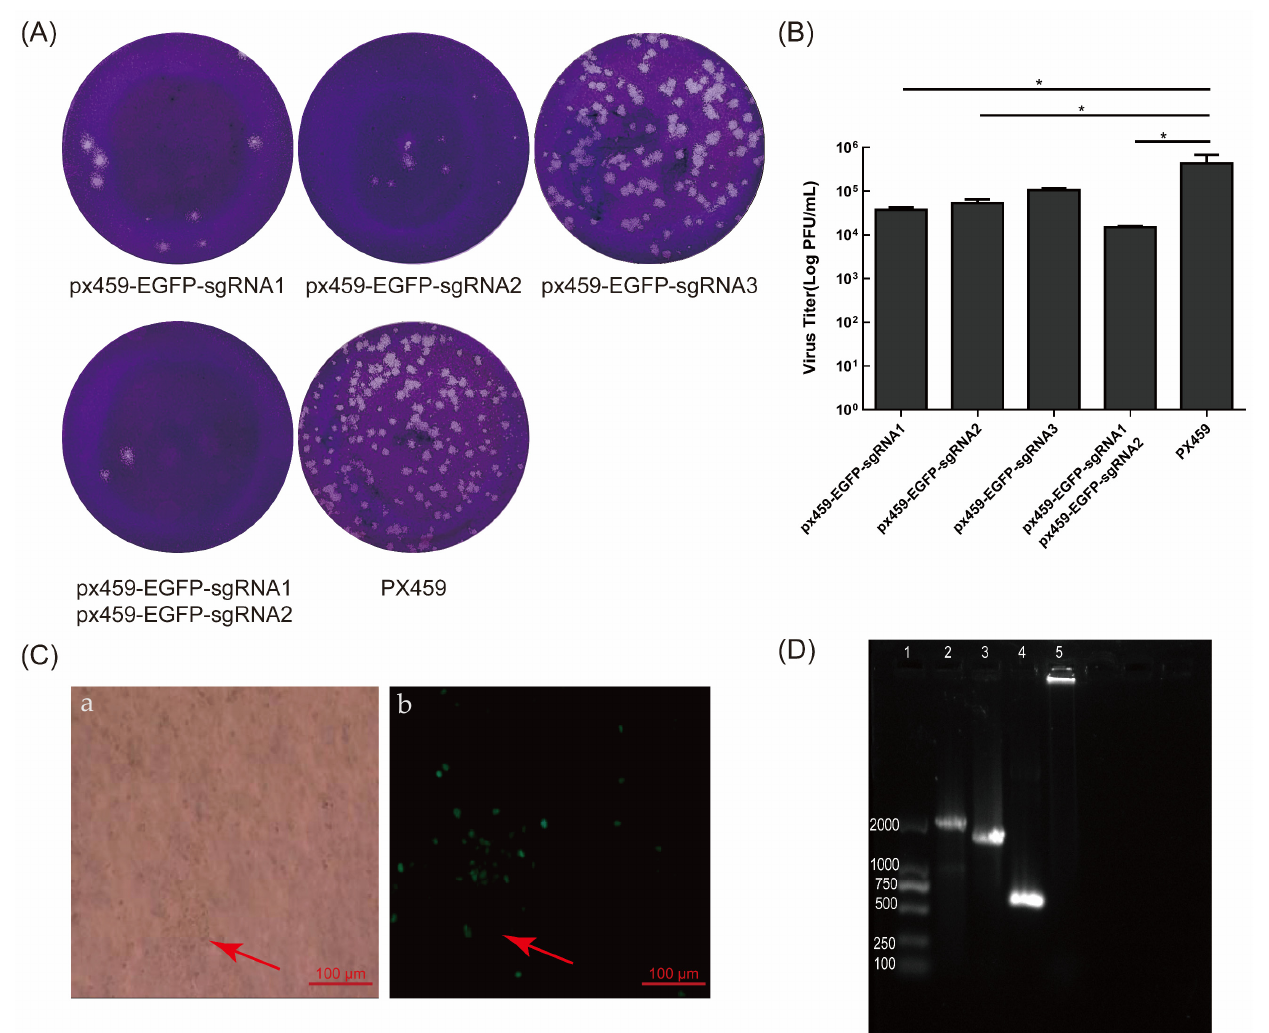
Figure 3. sgRNA of EGFP inhibited the formation of BoHV-1 gE/EGFP + plaques and the targeted deletion of EGFP. ( A ) The plaques with different sgRNAs of EGFP. Two micrograms of px459-gE- sgRNA1, 2, 3, or px459 were transfected into VERO E6 cells. After 12 h, the cells were infected with BoHV-1 gE/EGFP + (MOI = 1) and the virus was fixed and stained for plaque testing at 72 hpi. ( B ) The virus titer with sgRNA of EGFP editing on MDBK cells. ( C ) The cytopathic effect and no fluorescence of BoHV-1 gE/EGFP − ( Ca ) bright field; ( Cb ) fluorescence field. The red arrow indicates first-generation BoHV-1 gE/EGFP − recombinant viruses. ( D ) PCR identification of BoHV-1 gE/EGFP − . The purified viral genome was extracted and PCR amplification was performed using BHV-gE-F/R primers. The negative control was double distilled water. Lane 1: DNA marker 2000, lane 2: wtBoHV-1, lane 3: BoHV-1gE/EGFP + , lane 4: BoHV-1gE/EGFP − , lane 5: negative control. The data are shown as mean ± SD; * p <